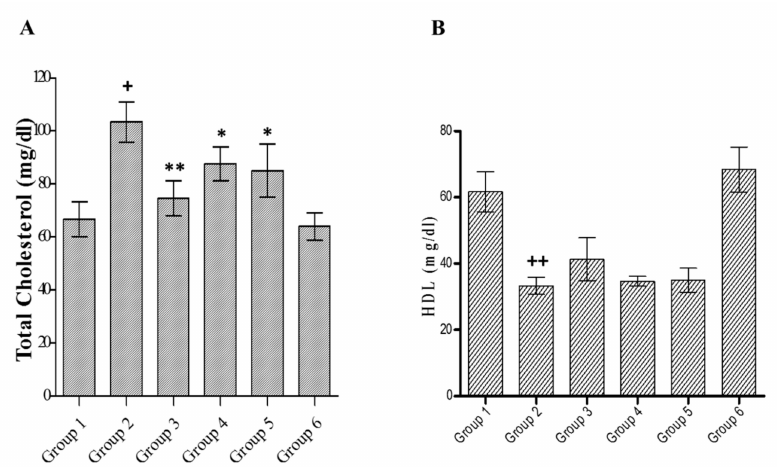
Figure 6. E ff ect of C. lanceolatus methanolic extract on serum total cholesterol ( A ) and high-density lipoprotein (HDL) ( B ) levels. The results are expressed as a mean ± SD ( n = 5). Group 1: Normal control; Group 2: Diabetic control; Group 3: Diabetic rats treated by glibenclamide; Group 4: Diabetic rats fed with C. lanceolatus extract (200 mg / kg); Group 5: Diabetic rats fed with C. lanceolatus extract (400 mg / kg); Group 6: C. lanceolatus extract (400 mg / kg) control. + p < 0.01 and ++ p < 0.001 compared to normal control. * p < 0.05 and ** p < 0.01 compared to the diabetic control.